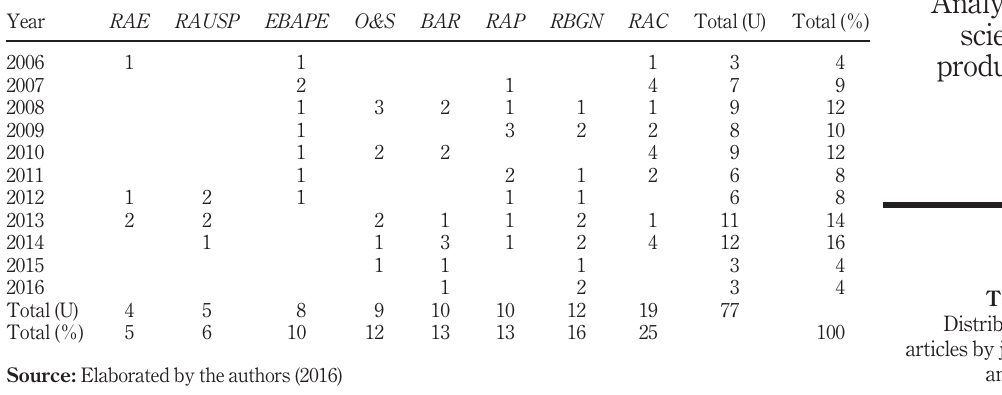
Table II. Distribution